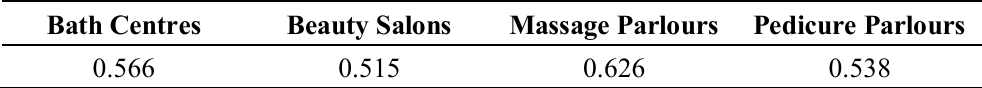
Table 4. Pearson correlation coefficients between hepatitis B morbidity and the type of service